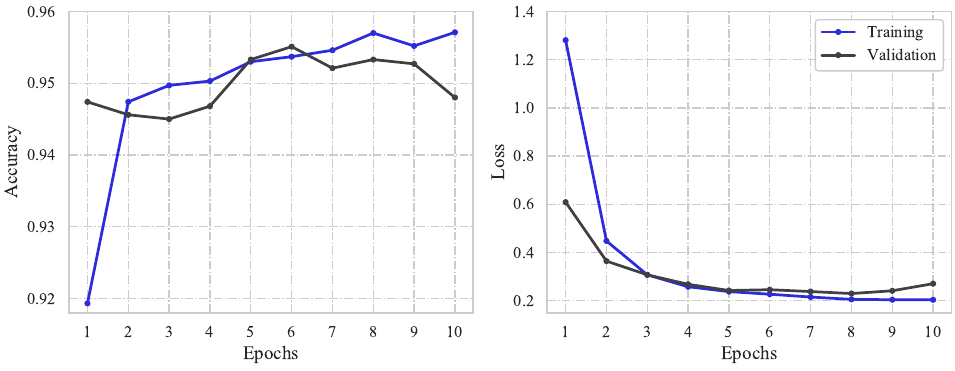
Figure 6. Validation and training accuracy as well as validation and training loss over 10 epochs for the CNN model variant remove keywords .